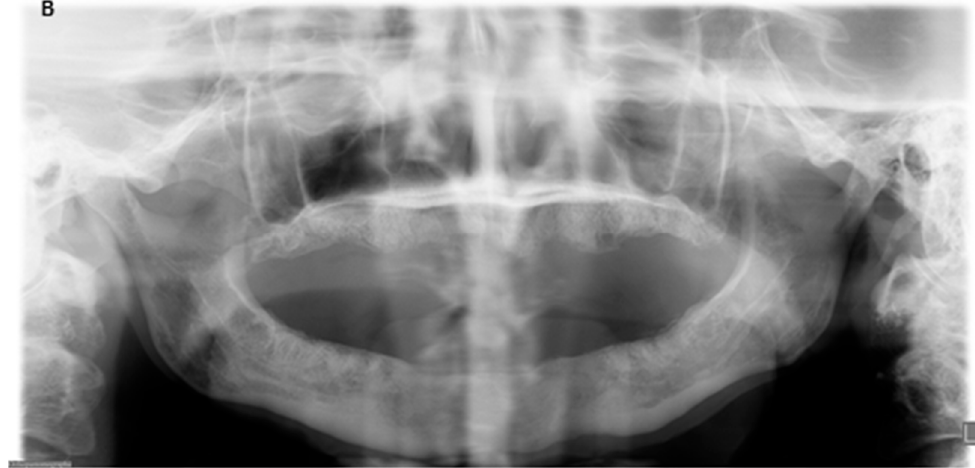
Figure 2. Radiologic findings before surgery and nine months after surgery. ( A ) Panoramic radiograph with extensive osteolysis, extending from region 46 to 34 up to the inferior border in the region of the symphyse; ( B ) Panoramic radiograph nine months post ‐ operatively with healed, smooth edges of the mandibular body.